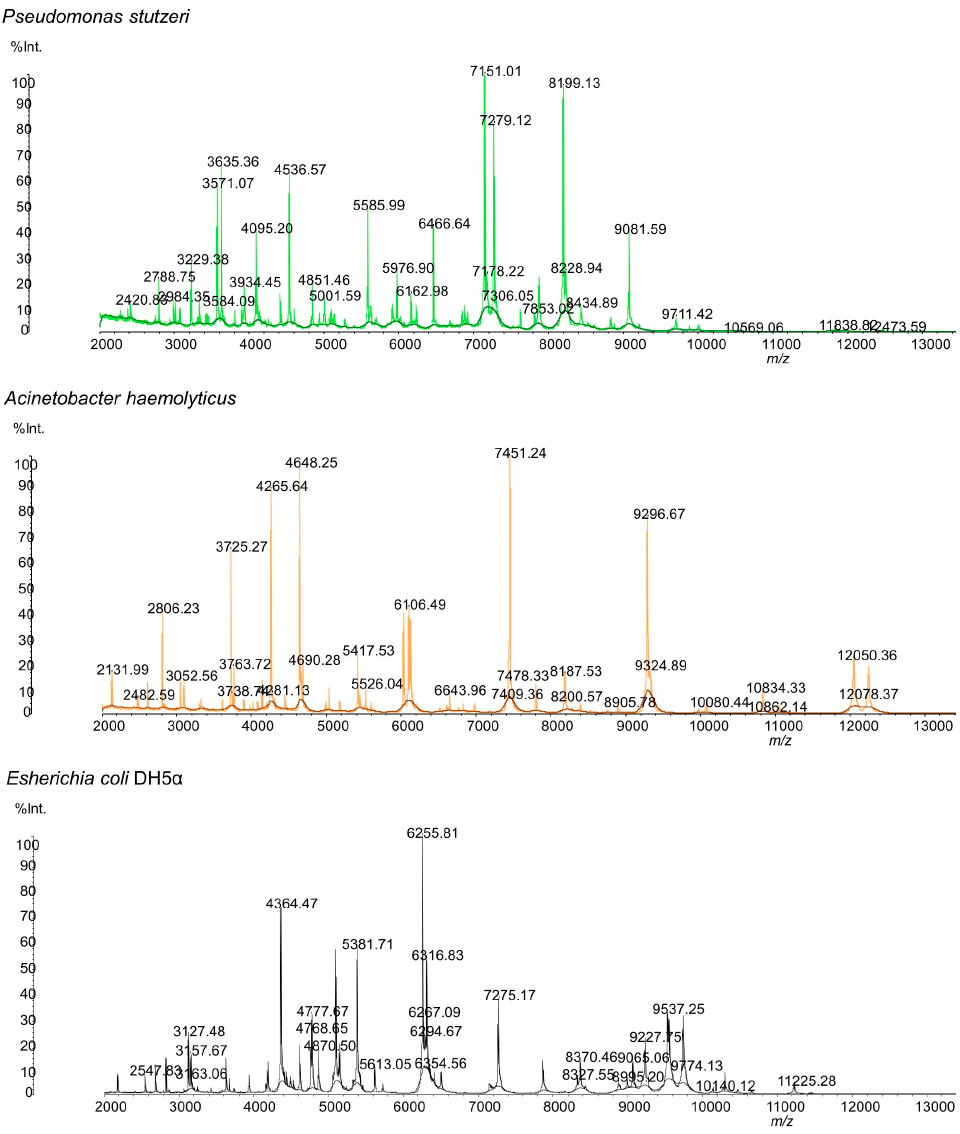
Figure 1. MALDI mass spectra of whole cells of the isolated bacteria and of the calibrant ( E. coli ) in CHCA matrix.